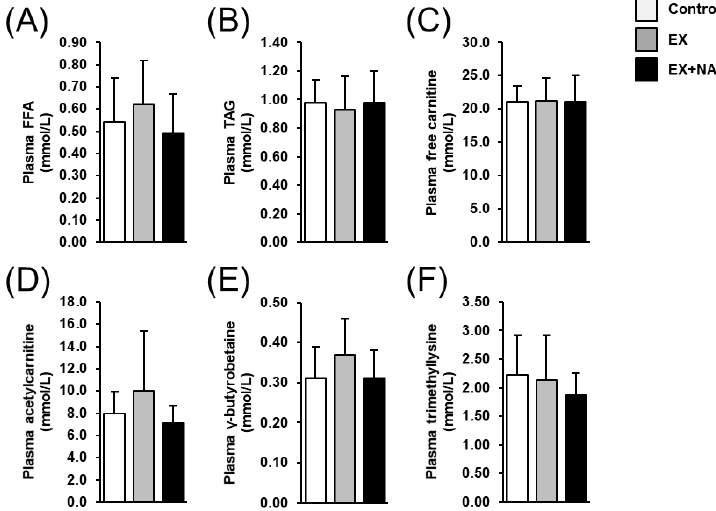
Figure 5. Plasma concentrations of metabolites related to fatty acid metabolism ( A ), free fatty acids (FFA); ( B ), triacylglycerols (TAG; ( C ), free carnitine; ( D ), acetylcarnitine; ( E ), γ -butyrobetaine; ( F ), trimethyllysine) in sedentary mice fed an NA (nicotinic acid) adequate diet (Control) and mice subjected to regular endurance exercise fed either an NA adequate diet (EX) or a high NA diet (EX + NA) for 6 weeks. Bars represent means ± SD for n = 10 animals per